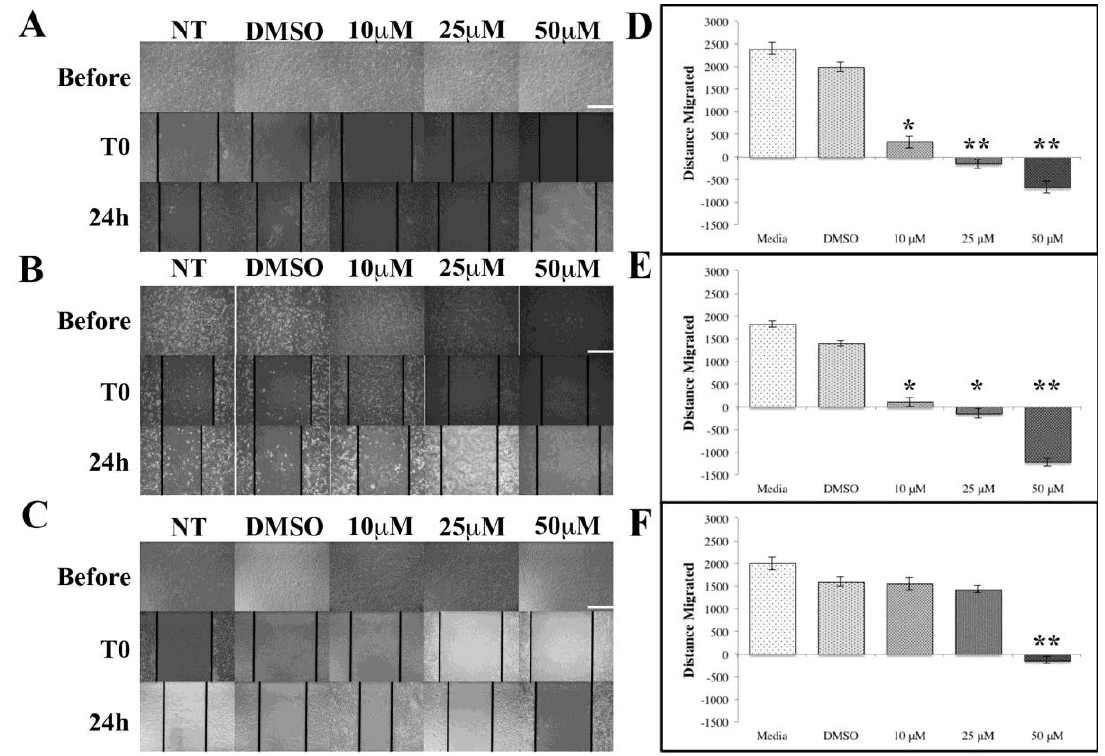
Figure 2. ASX inhibits cell migration. ( A ) Images of MCF7 cells prior to, immediately after, and 24 h post-scratch with indicated ASX concentrations; ( B ) MDA-MB-231 cells prior to, immediately after, 24 h post-scratch with indicated ASX concentrations; ( C ) MCF10A cells prior to, immediately after, and 24 h post-scratch with indicated ASX concentrations. Scale bars = 50 m; ( D ) Quantification of ( A ); ( E ) Quantification of ( B ); ( F ) Quantification of ( C ). * p < 0.05, ** p < 0.01.